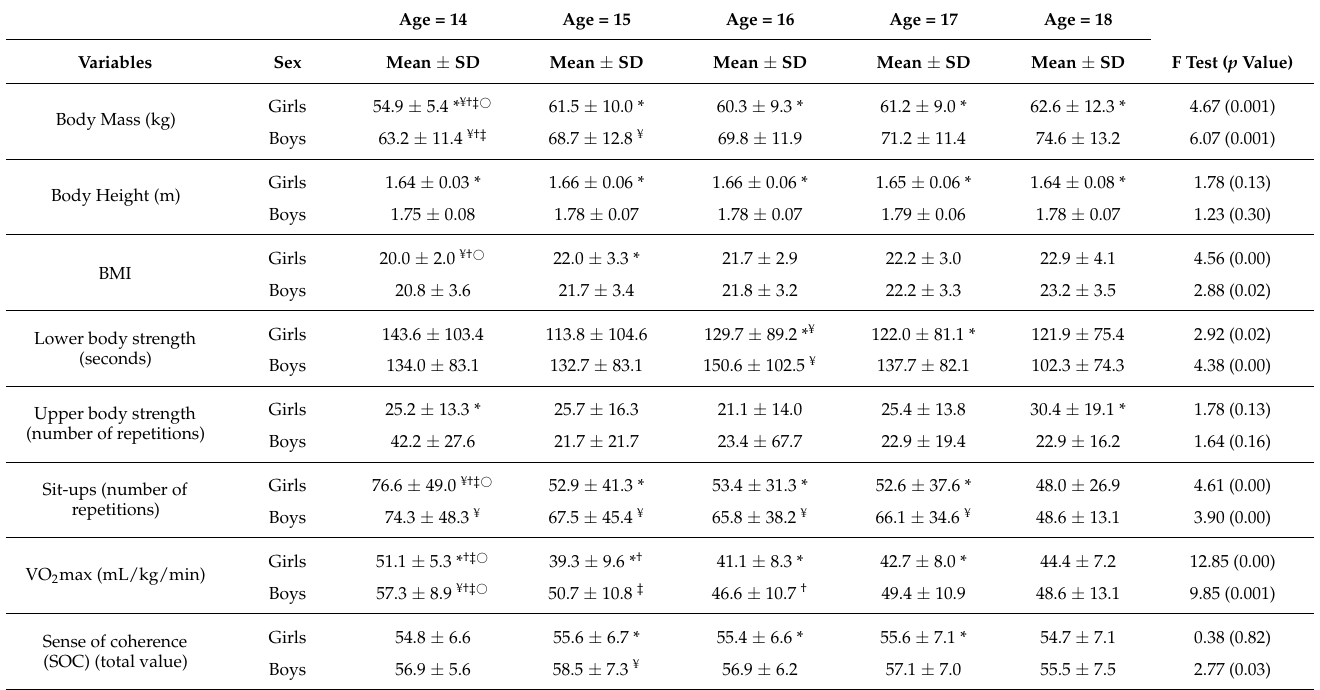
Legend: * Indicates significant differences between boys and girls in the accompanying age group at p < 0.05. ¥ Indicates values significantly different from those obtained in 18-year-old adolescents at p < 0.05. † Indicates values significantly different from those obtained in 17-year-old adolescents at p < 0.05. ‡ Indicates values significantly different from those obtained in 16-year-old adolescents at p < 0.05. different from those obtained in 15-year-old adolescents at p <